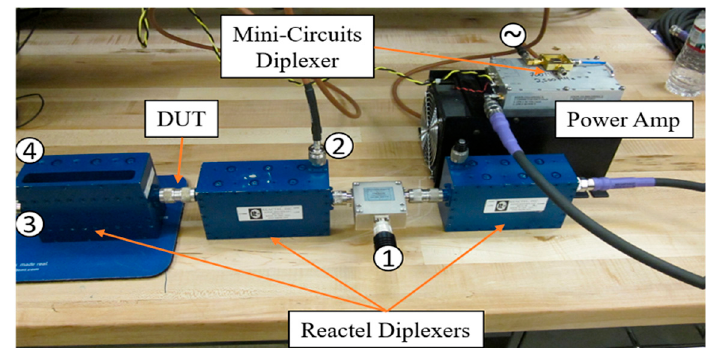
Figure 11. Photograph of the diplexers and 10-W power amplifier.